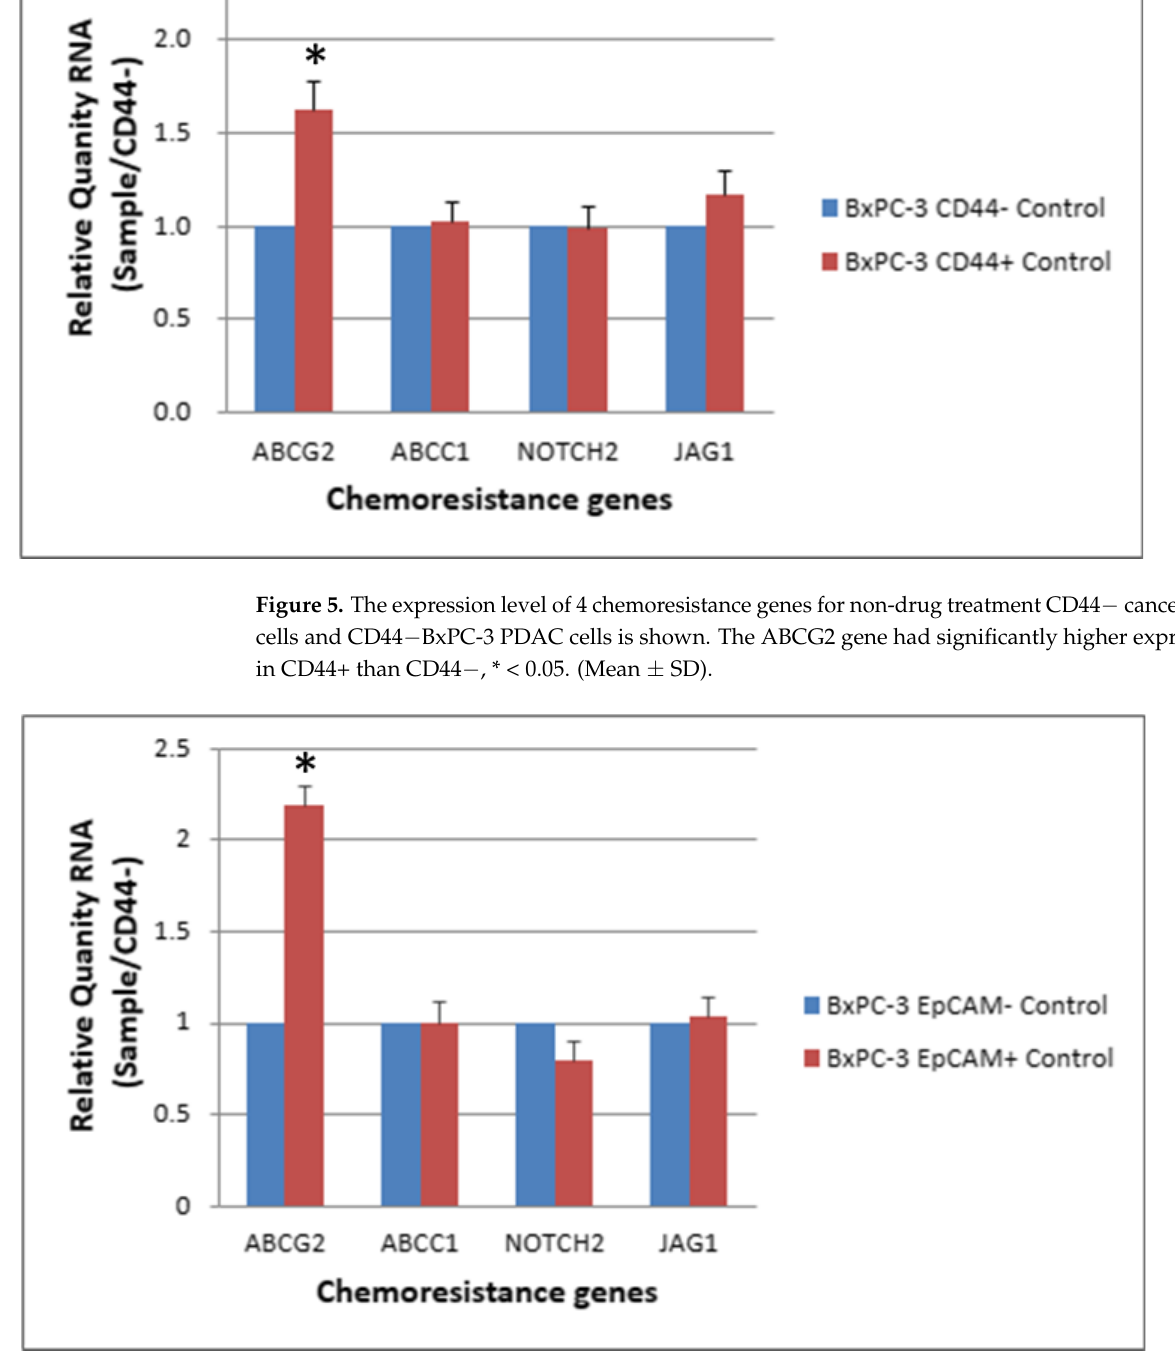
Figure 6. The expression level of 4 chemoresistance genes for non-drug treatment EpCAM+ cancer stem cells and EpCAM− BxPC-3 PDAC cells is shown. The ABCG2 gene had significantly higher expression in EpCAM+ than EpCAM−, * < 0.05. (Mean ± SD).